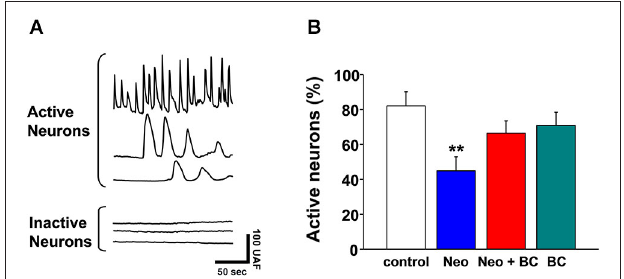
FIGURE 3 | Chronic application of Neocuproine decreases the number of active neurons . (A) The top traces show typical calcium transients observed in active hippocampal neurons in culture. The bottom traces show the lack of calcium transients in inactive hippocampal neurons in culture. Each trace corresponds to the signal recorded in a single cell. (B) The graph summarizes the percentage of active hippocampal neurons under different treatments: untreated (control) or treated with Neocuproine (Neo, 10 µ M) in the absence or presence of Bathocuproine (BC, 10 µ M) for 12 h. Values are mean ± SEM ( N = 3). **, p <